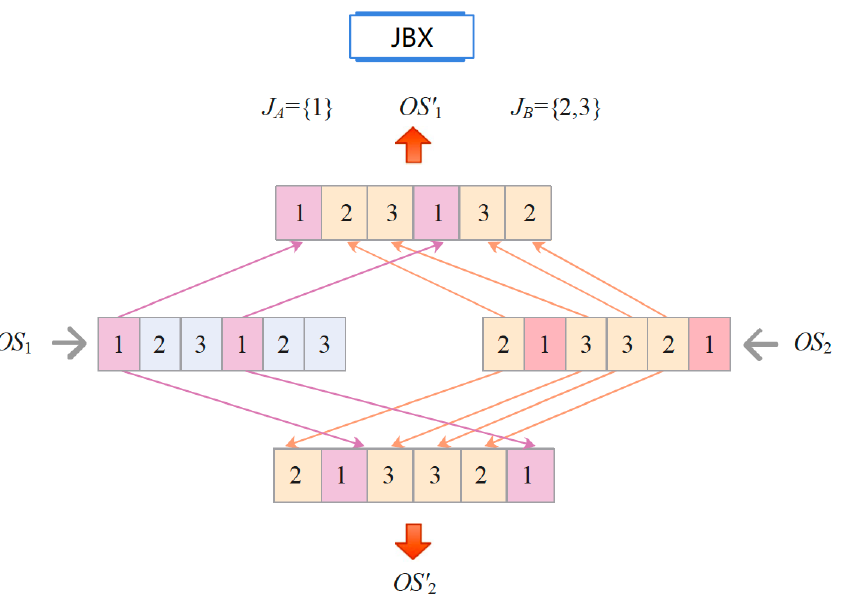
Figure 4. Example of a job-based crossover (JBX).